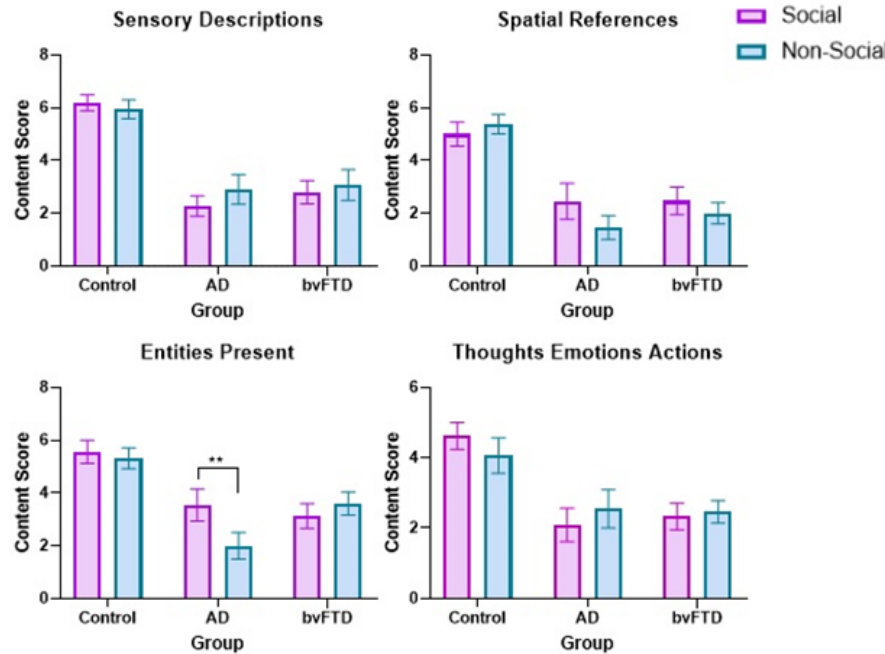
Figure 3. Mean social and non-social scene construction contextual detail scores in the congruent condition. Whiskers represent standard error of measurement. AD = Alzheimer’s disease. bvFTD = behavioural variant of frontotemporal dementia. ** = p < 0.01. Table 3. Subjective ratings for each condition in participant